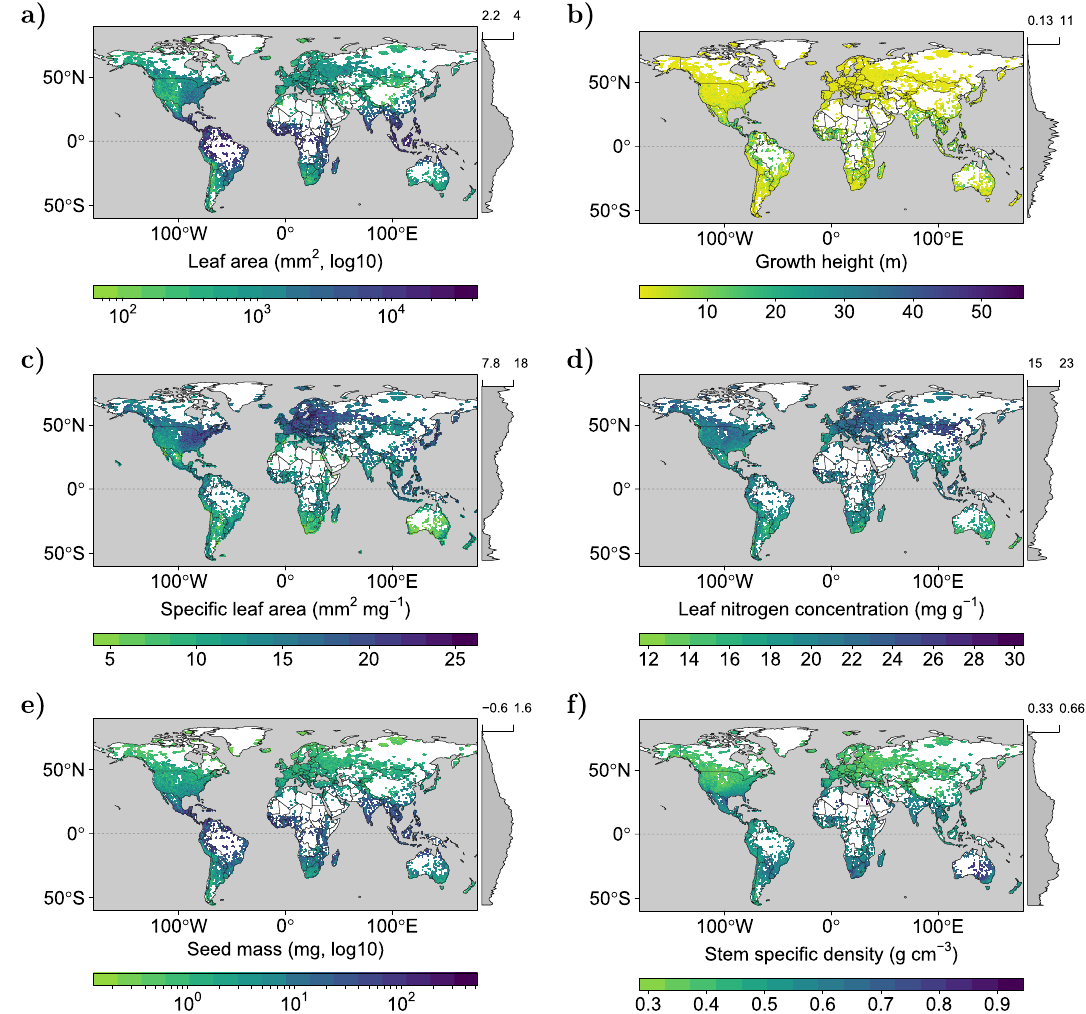
Figure 5. Global trait distribution maps. Global maps of mean plant functional traits produced by inverse- distance weighted interpolation on ensemble predictions for leaf area ( a ), growth height ( b ), specific leaf area ( c ), leaf nitrogen concentration ( d ), seed mass ( e ), stem specific density ( f ) including latitudinal distribution. Values of leaf area and seed mass were log 10 -transformed for improved